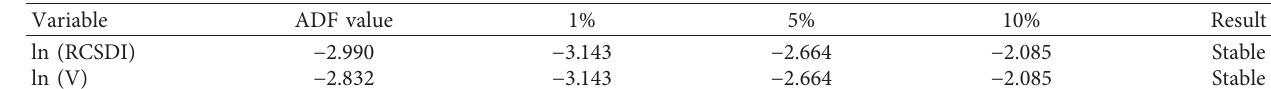
Figure 2: Daily yield linearity of A-share market composite index. Table 1: Stationarity test results.